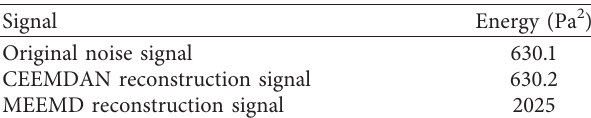
Figure 23: MEEMD reconstruction signal error. Table 4: Energy of each